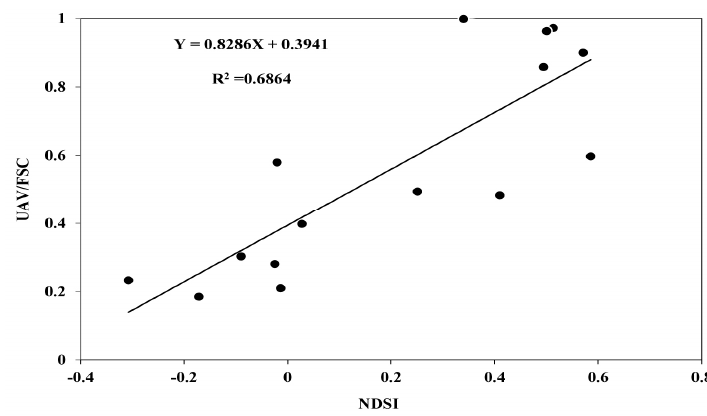
Figure 3. Scatter diagram of UAV FSC versus MODIS NDSI.